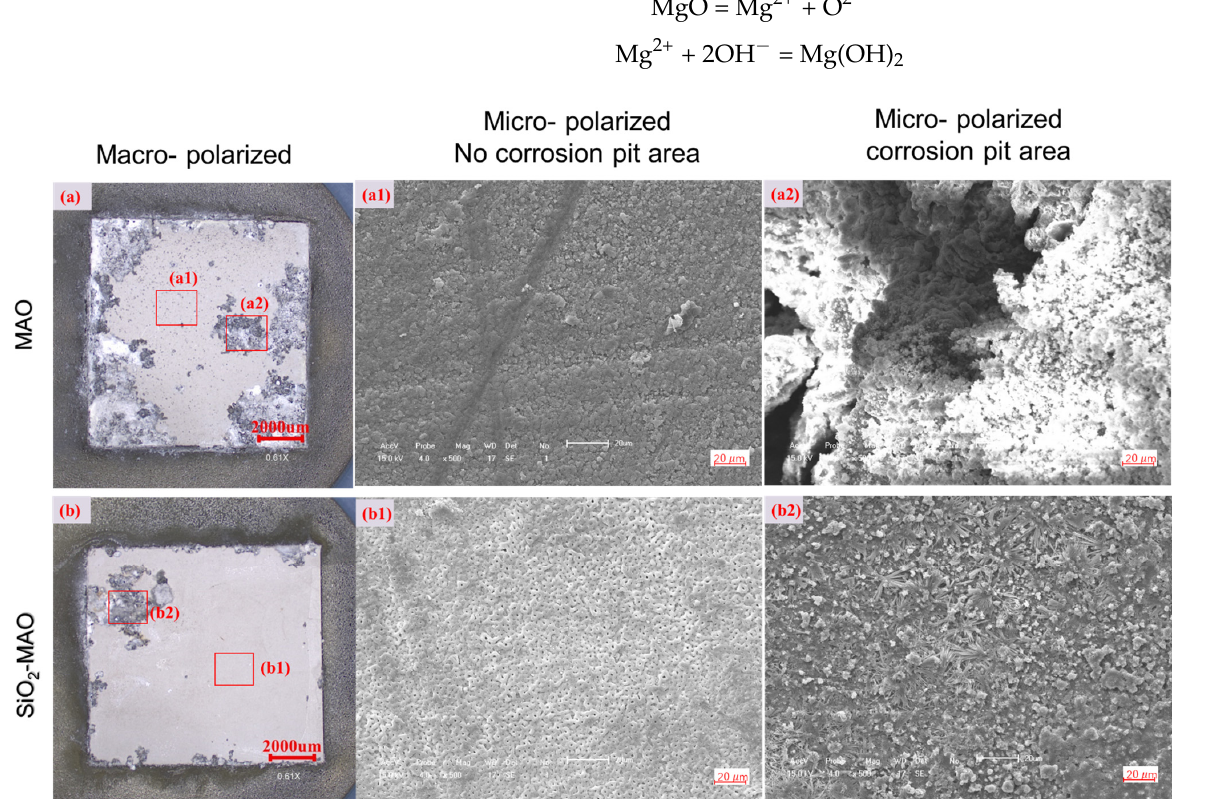
Figure 8. Macroscopic and microscopic appearance of the samples after corrosion. ( a , b ) the macro- scopic morphology of the MAO coating and SiO 2 /MAO coating after corrosion; ( a1 , b1 ) microscopic morphology of the corrosion-free pit area of the two coatings; ( a2 , b2 ) the microscopic morphology of the corrosion pit area of the two coatings.